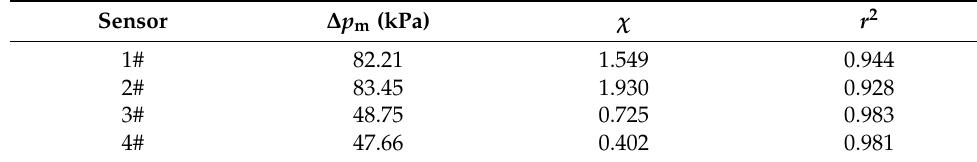
Figure 8. Typical overpressure curves and the determination of peak overpressure. Table 4. The curve-fitting parameters for overpressure of test No. 003.